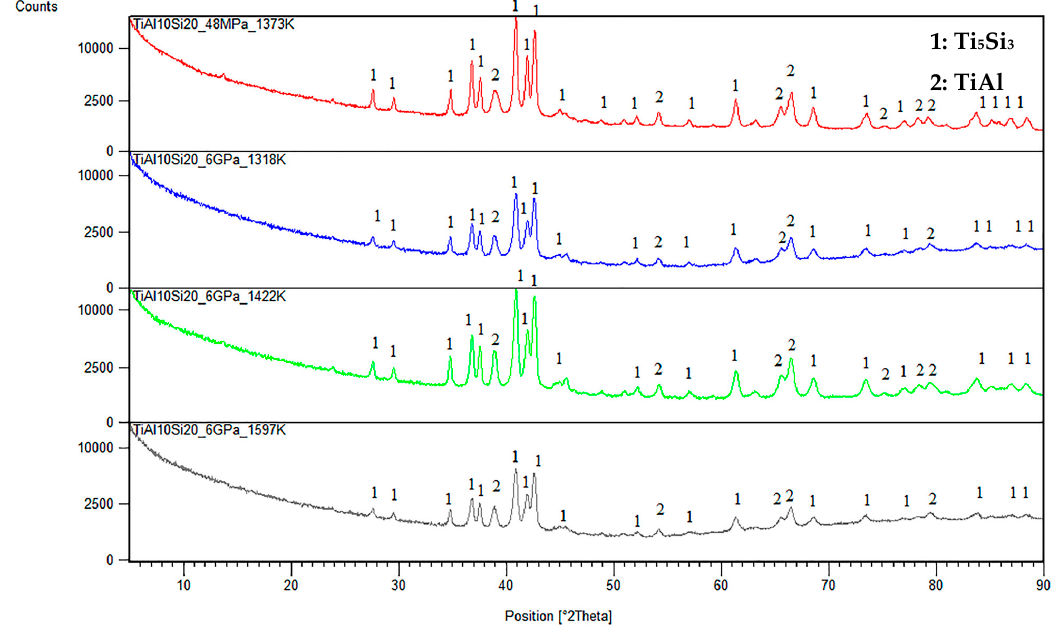
Figure 4. XRD patterns of powders after milling and compacted alloys prepared by SPS. 1: Ti 5 Si 3 ; 2: TiAl.